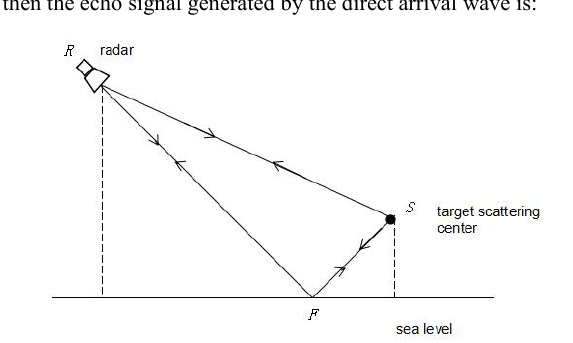
Figure 1. A four-path model for multipath propagation of